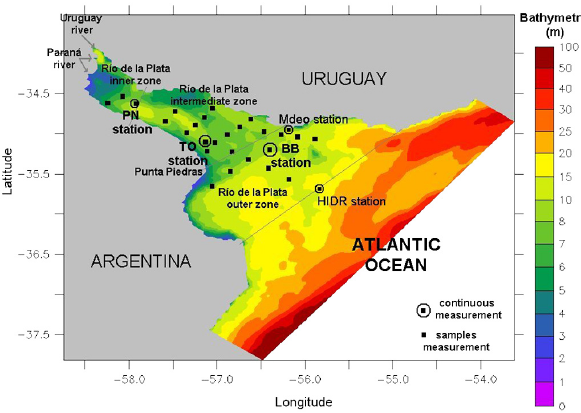
Fig. 1. Bathymetry, location, measurements stations, and zones of the Río de la Plata.